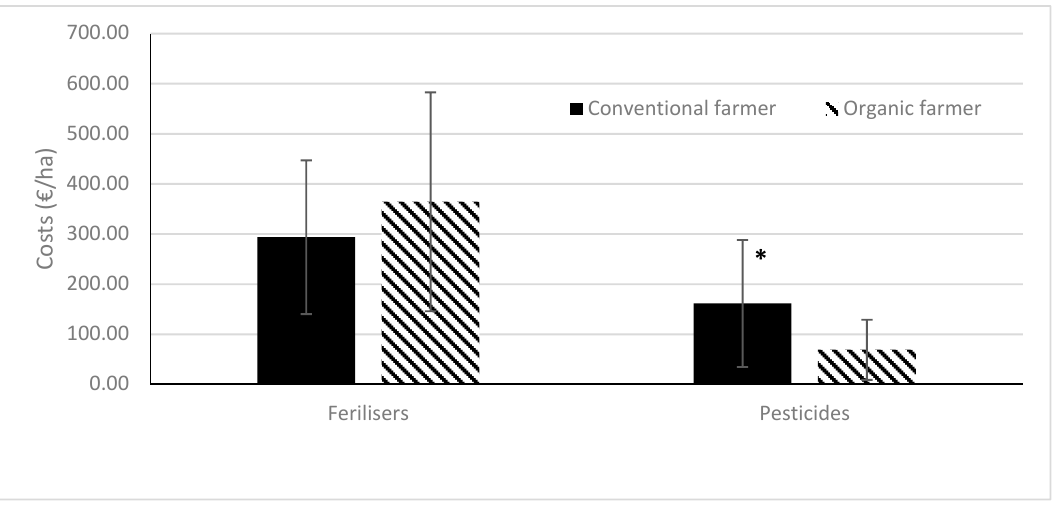
Figure 7. Annual cost of fertilizer and pesticides among organic ( n = 16) and conventional ( n = 23) olive farmers in Messenia, Greece. The error bars indicate standard deviations. The asterisk (*) marks statistically significant differences (<0.05) between the two groups of farmers.